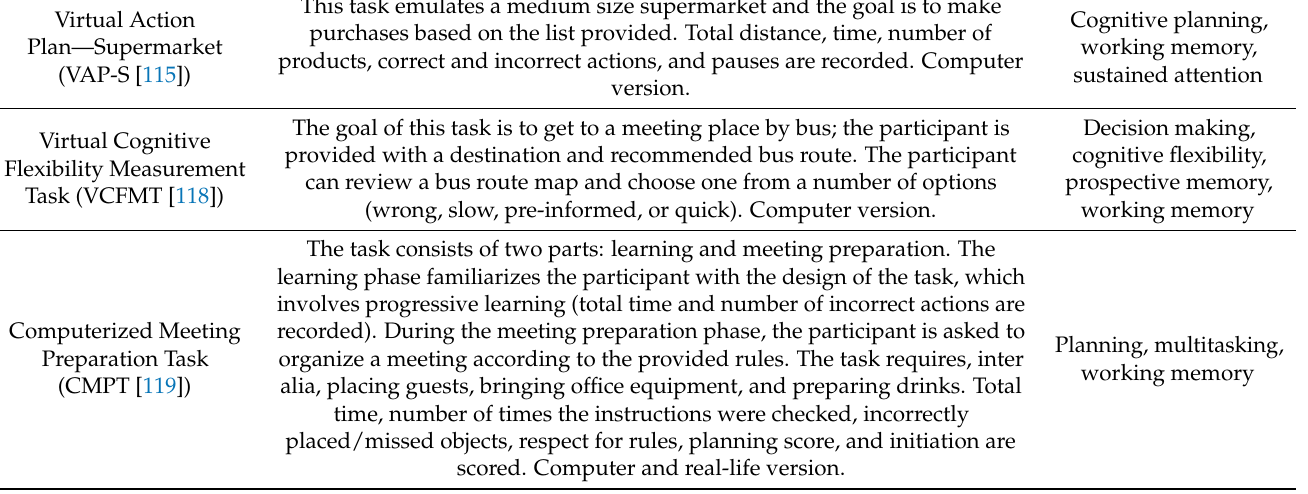
Table 5. Descriptions of virtual reality tools for measuring executive functions in schizophrenia.